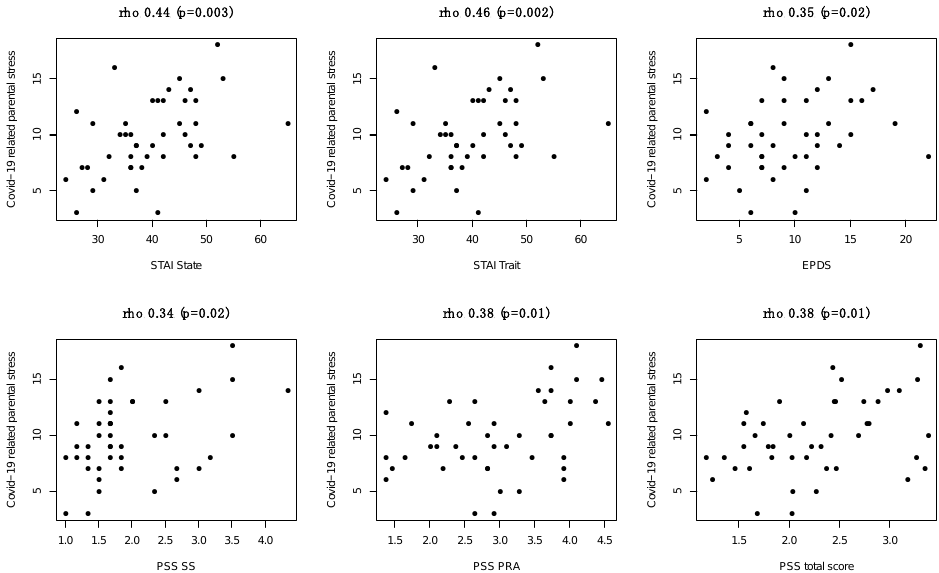
Figure 2. Association between COVID-19 related parental stress and STAI state, STAI trait, EPDS, PSS-SS, PSS-PRA and PSS-total score.